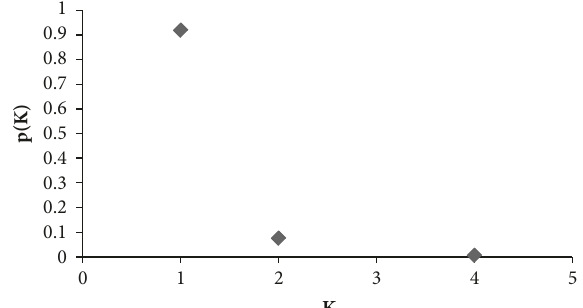
Figure 5: Probability distribution of node degree in Space L space of complex network in Nanjing metro.